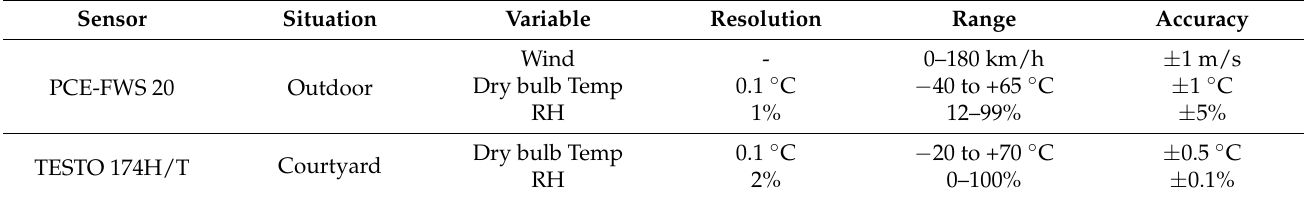
Table 2. Technical data of the measurement equipment.